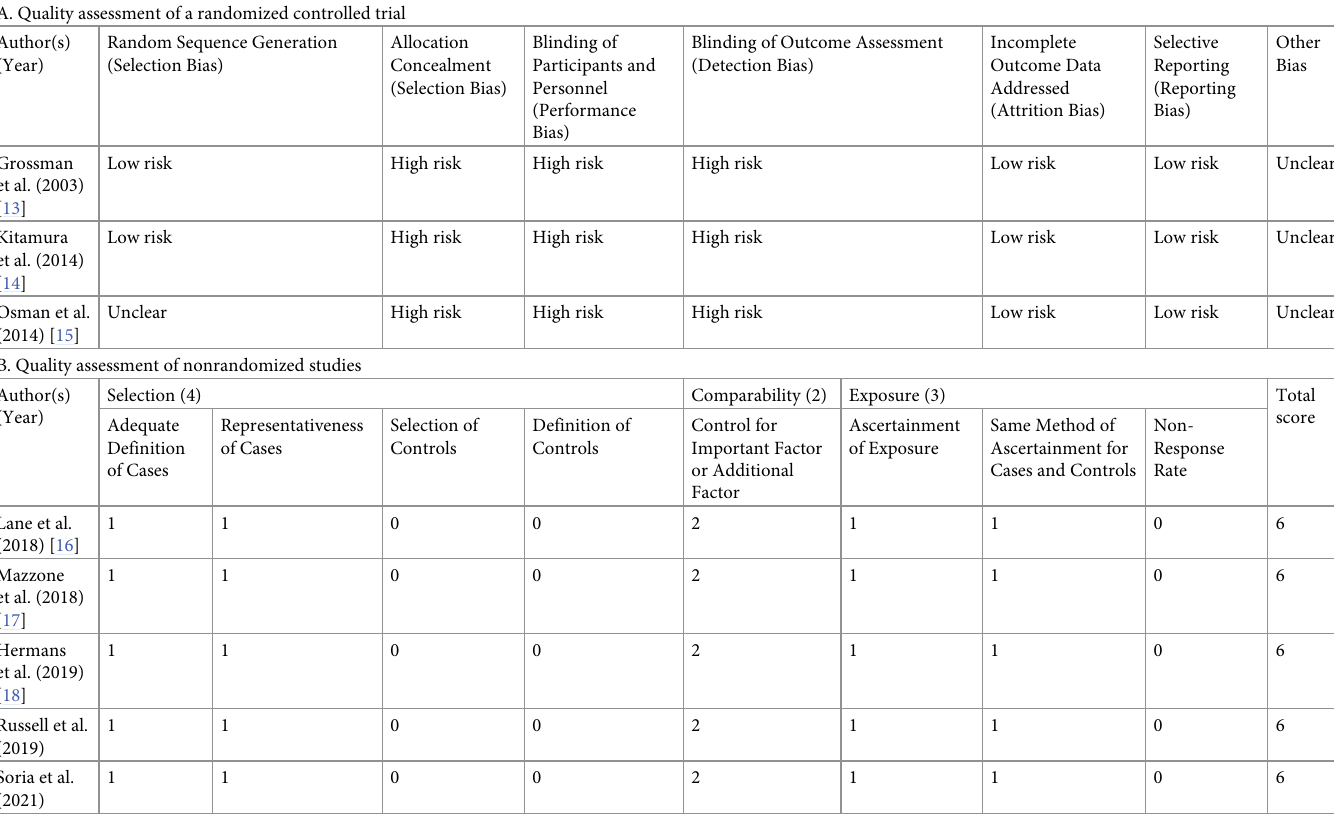
Table 2. Results of quality assessment by the Cochrane risk-of- bias tool (A) and NOS